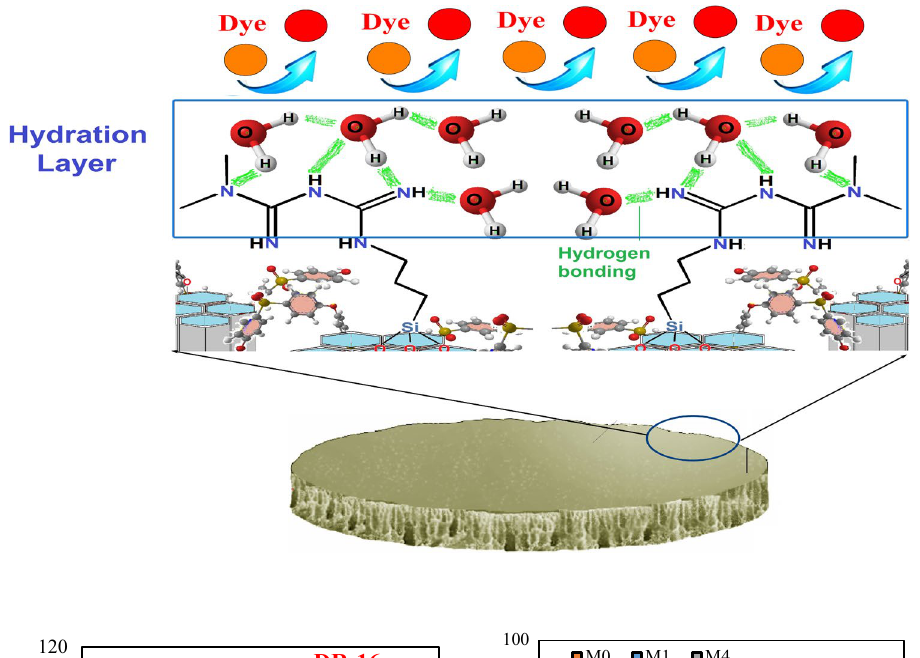
Fig. 10 Dye rejection efficiency ( a ) and dye flux ( b ) of the membranes in different concen-